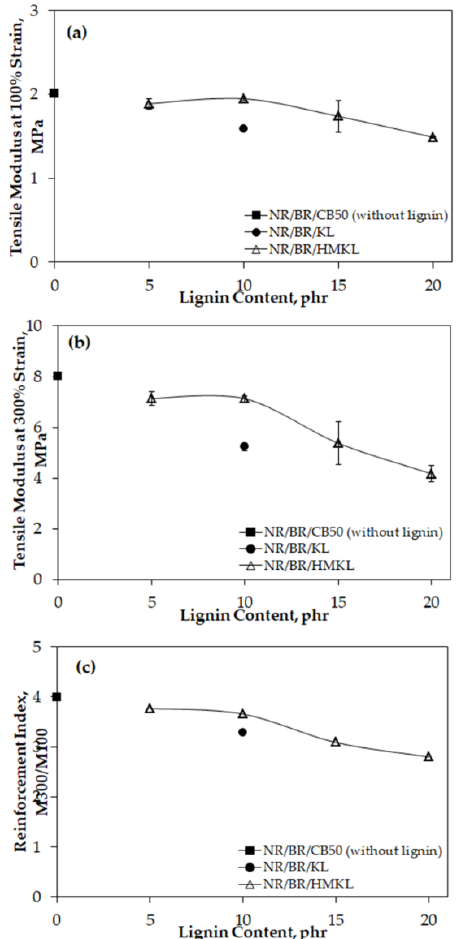
Figure 7. The e ff ect of HMKL content on ( a ) the tensile modulus of lignin-filled NR / BR compounds Figure 7. The effect of HMKL content on ( a ) the tensile modulus of lignin-filled NR/BR compounds at 100% strain, ( b ) the tensile modulus of lignin-filled NR / BR compounds at 300% strain, and ( c ) the at 100% strain, ( b ) the tensile modulus of lignin-filled NR/BR compounds at 300% strain, and ( c ) the reinforcement index of lignin-filled NR / BR reinforcement index of lignin-filled NR/BR compounds.